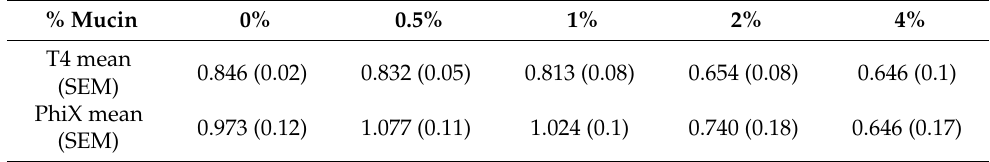
Table 3. Fold change in E. coli growth relative to control in static system with phage (MOI 1).